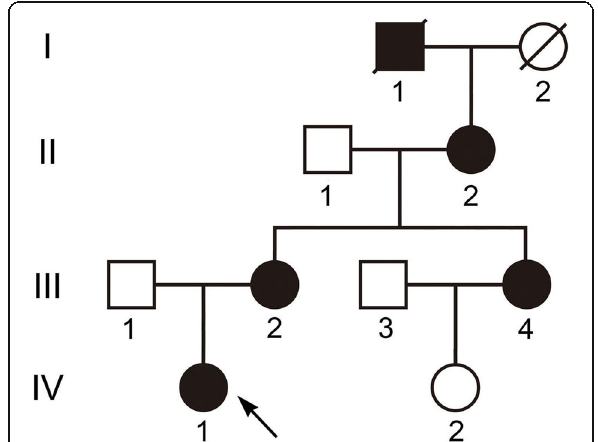
Fig. 1 Pedigree of the Chinese family with autosomal dominant congenital cataracts and microphthalmia. Squares and circles indicate males and females, respectively. Filled symbols indicate affected members, and empty symbols indicate unaffected individuals. The diagonal line indicates a deceased family member and the arrow indicates the